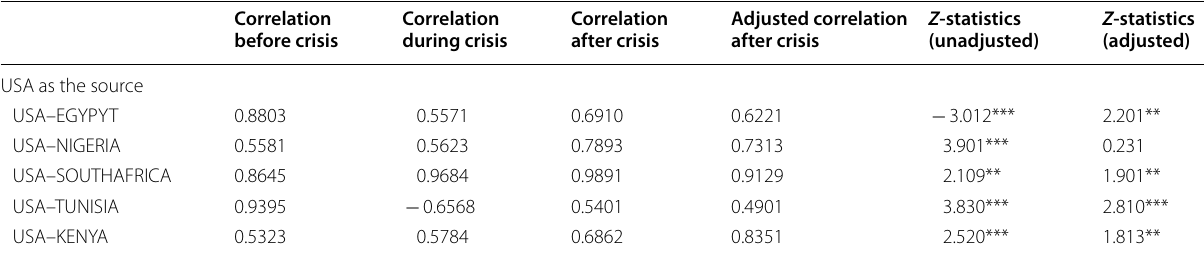
Table 4 Test of significant increases in correlation coefficients (USA as the source of contagion). Source :